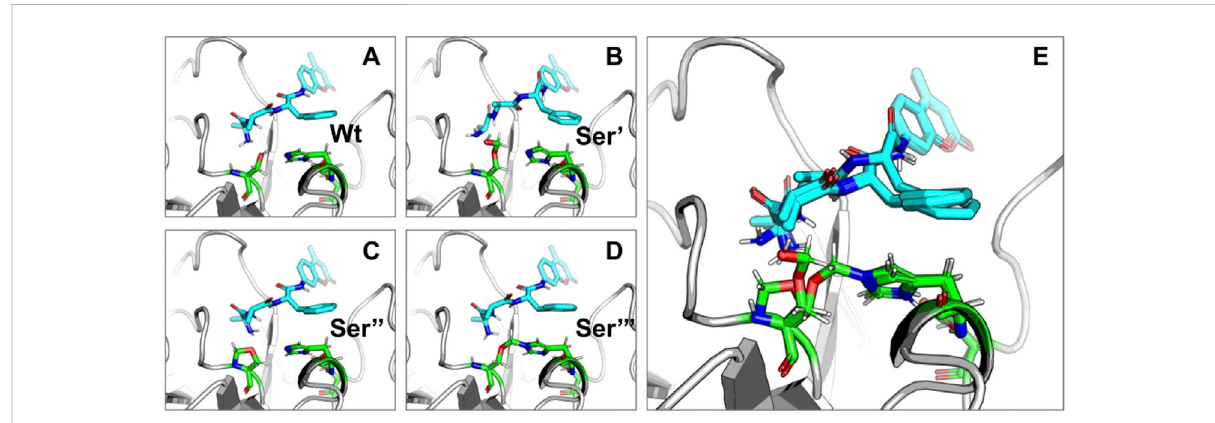
FIGURE 8 Binding of substrate (AMC) with Wt and HCHO modi fi ed CHT as obtained by molecular docking simulations. (A – D) Different modes of AMC binding with CHT on modi fi cation of the active site Serineresidue (Ser-195) as mentioned previously [Wt indicates the wild type Ser-195 residue]. (E) Overlapping view of the different binding interactions; residue modi fi cation causes no major change in binding mode of AMC with CHT.